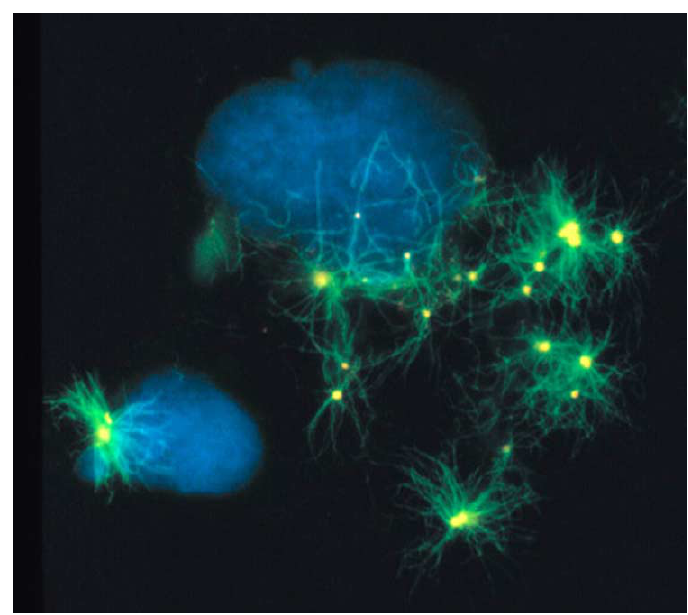
Fig. 3. Centrosomes are abnormal in size, shape and number in human tumor cells. Abnormal centrosomes in a breast tumor cell (right, yellow) compared with a normal diploid cell (lower left). Newly nucleated microtubules (green) arise from a single centrosome in the nontumor cell (yellow, bottom left). In the tumor cell, multiple centrosomes of hetergeneous size, shape and number, nucleate microtubules (right) and contribute to the formation of multipolar spindles and chromosome missegregation (not shown). Blue, nuclei. Images: Steve Doxsey.